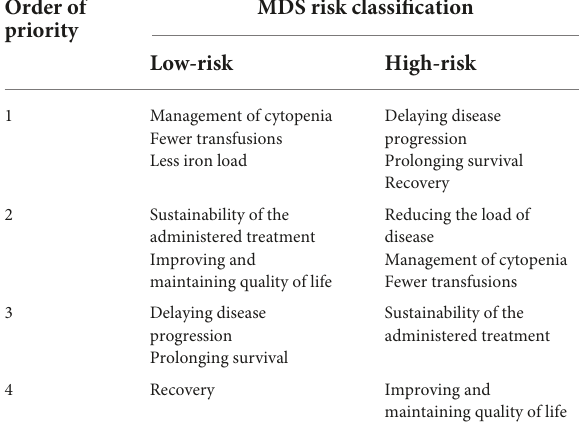
TABLE 4 New treatment strategies in low grade myelodysplastic syndromes